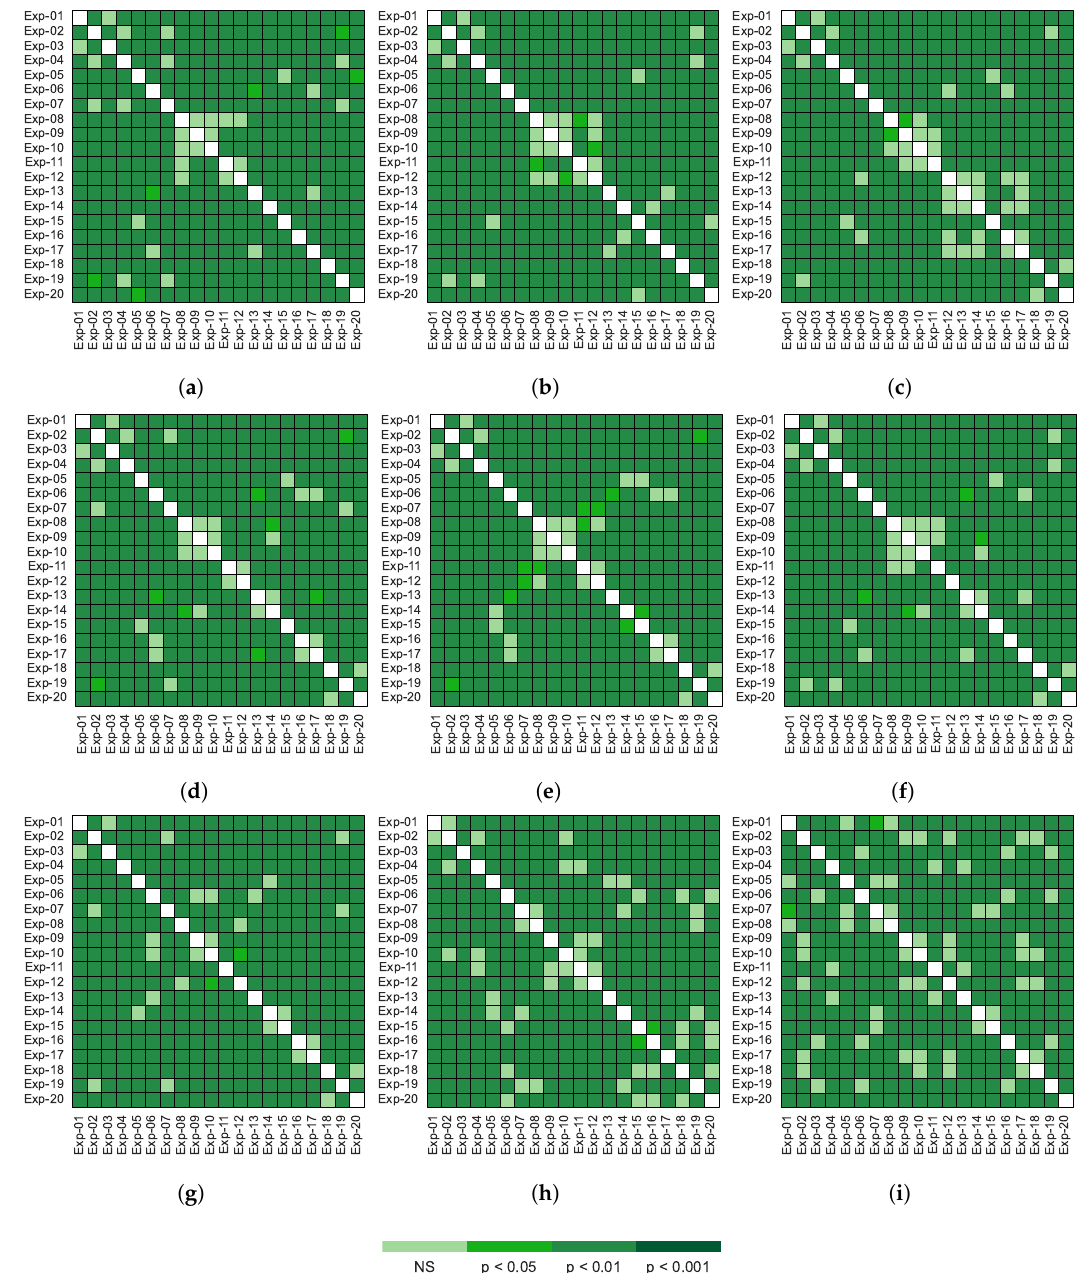
Figure 8. Nemenyi post hoc rankings pairwise comparison for each experiment for all performance metrics after 1000 bootstrap cycles. The probability bar shows the ( a ) Accuracy, ( b ) Balanced accuracy, ( c ) F 1 score, ( d ) F 2 score, ( e ) Matthew’s correlation coefficient. ( f ) Sensitivity. ( g ) Specificity. ( h ) Maxi- mum validation accuracy. ( i ) Number of epochs required to reach the maximum validation accuracy. The NS stands for no significant